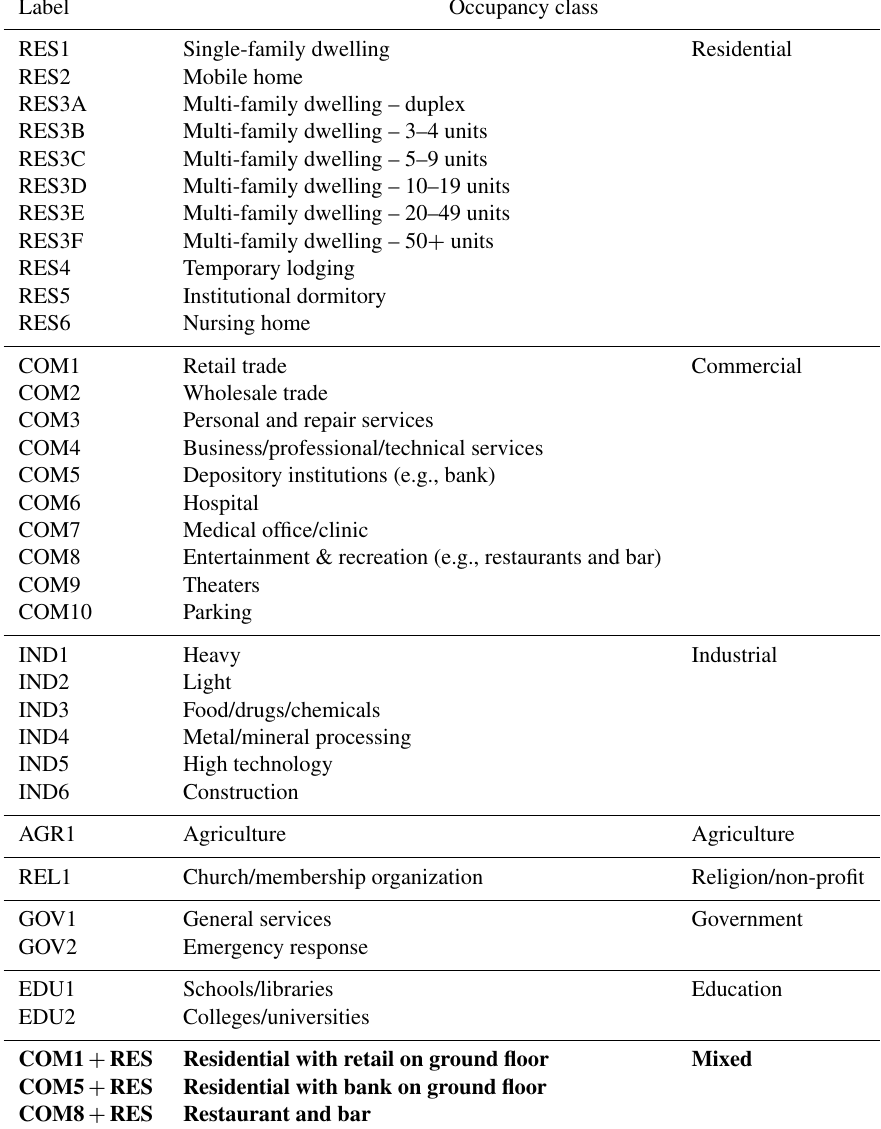
Table 1. Original HAZUS building occupancy classes (normal font) and derived mixed-occupancy classes (bold).